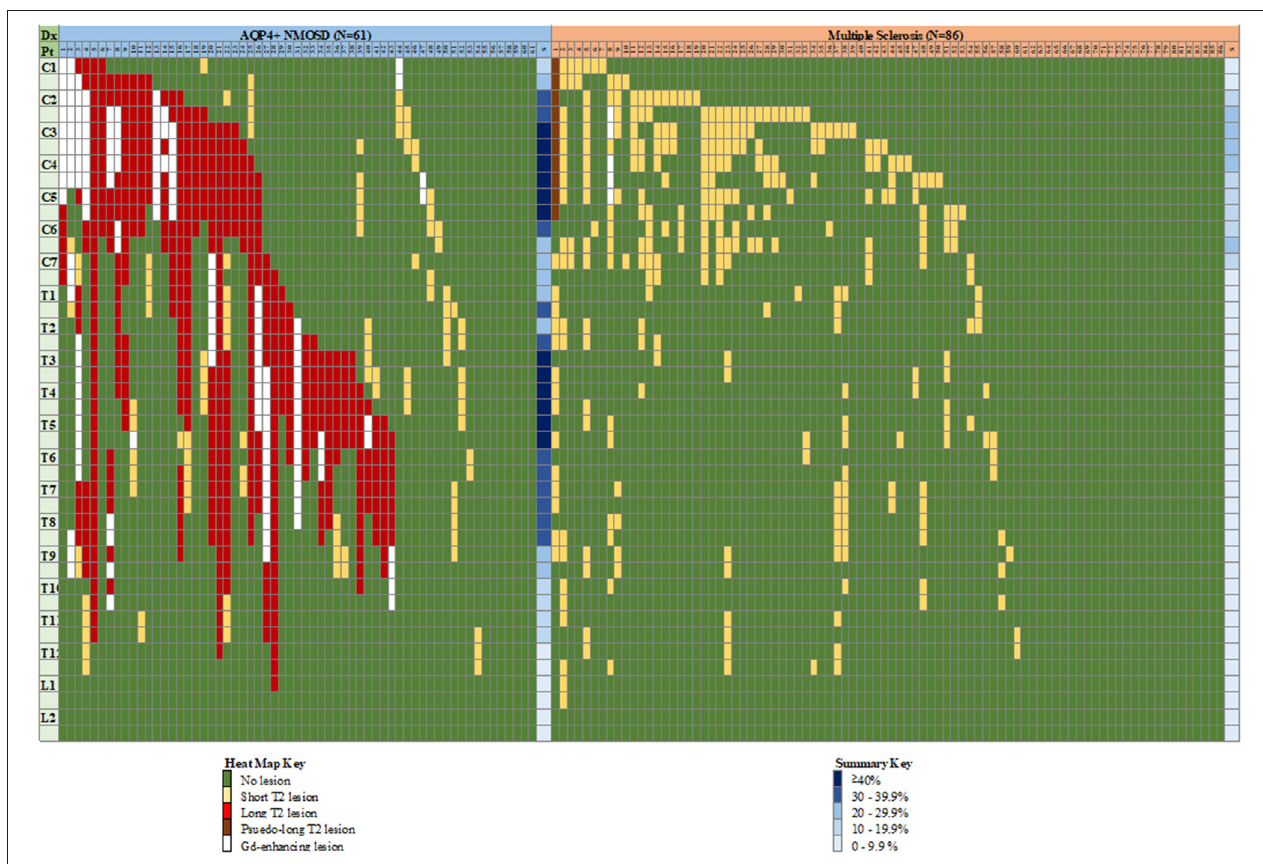
FIGURE 9 | “Heat map” of lesion location in the spinal cord of individual cases with NMOSD and multiple sclerosis. Vertical columns indicate individual patients as numbered, horizontal rows indicate hemi-vertebral distances (i.e., two rows = one vertebral segment). Representation of lesions is for lesions appearing at any time during the disease course for an individual patient, hence consecutive short lesions spanning more than 3 vertebrae can be seen (i.e., multiple short lesions at different times). See text for definition of pseudo-long T2 lesion. Columns at far right of each group indicate a summary (S) of relative frequency of lesions for each level (any type of lesion). Dx, diagnosis; Pt, patient; C, cervical; T, thoracic; L, lumbar; NMOSD, neuromyelitis optica spectrum disorder; S, summary.